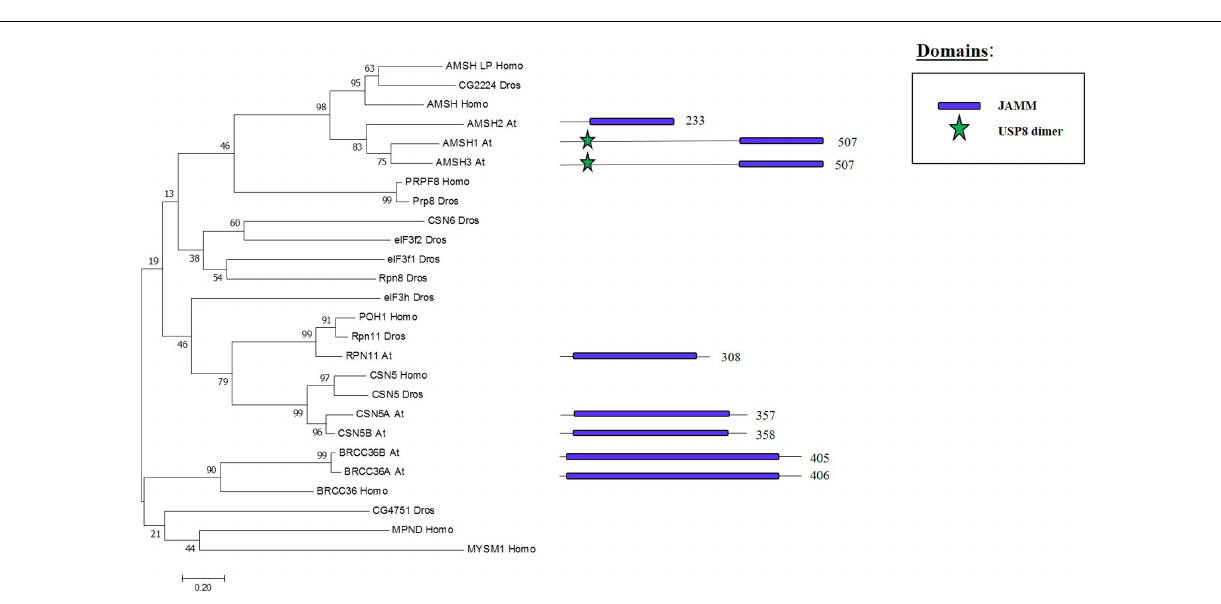
FIGURE 6 | Arabidopsis JAMM family and the high sequence similarity proteins in Humans and Drosophila. Phylogenetic analysis showing the 8 members of the JAMM family based on protein sequence percentage of similarity and their domains. The analysis was conducted in MEGA7 (Kumar et al., 2016). The tree was constructed by the Neighbor-Joining method with bootstrap resampling (5000 replicates). The numbers in the nodes indicate bootstrap values. The distances were computed using the Poisson method. Scale bars indicate units of the number of amino acid substitutions per site. The numbers in the domain representation indicate the amino acids